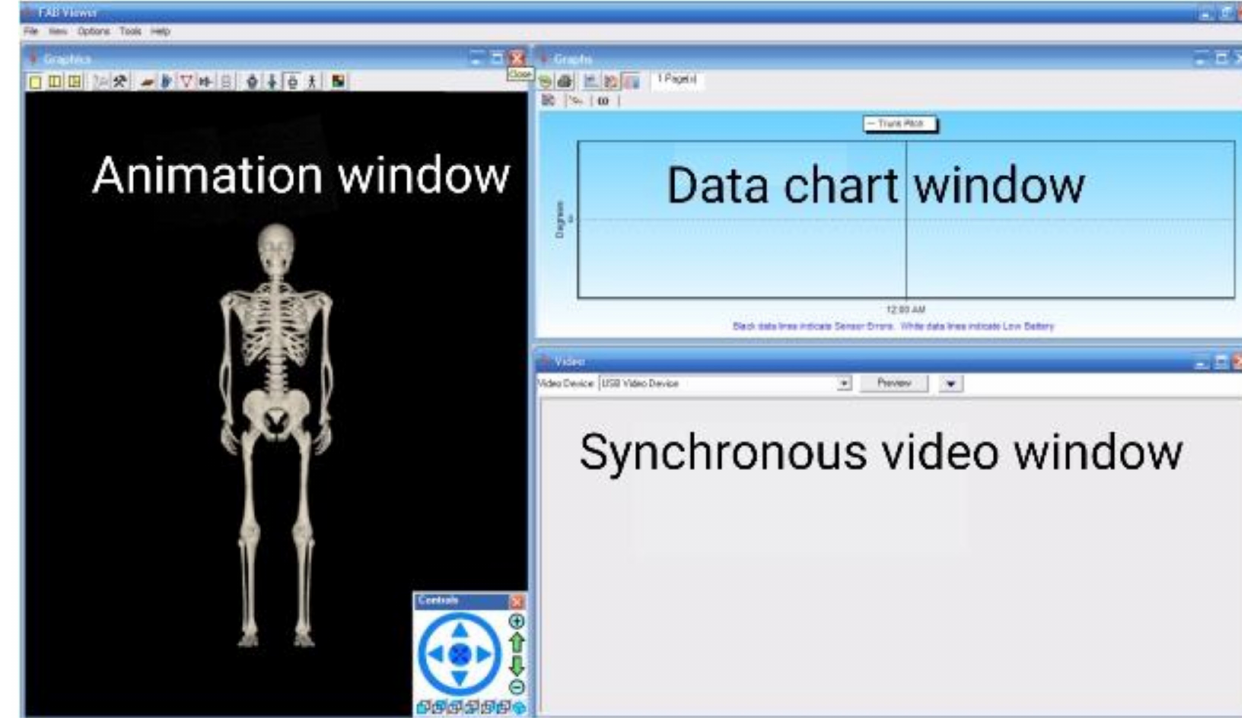
Figure 1. Software analysis